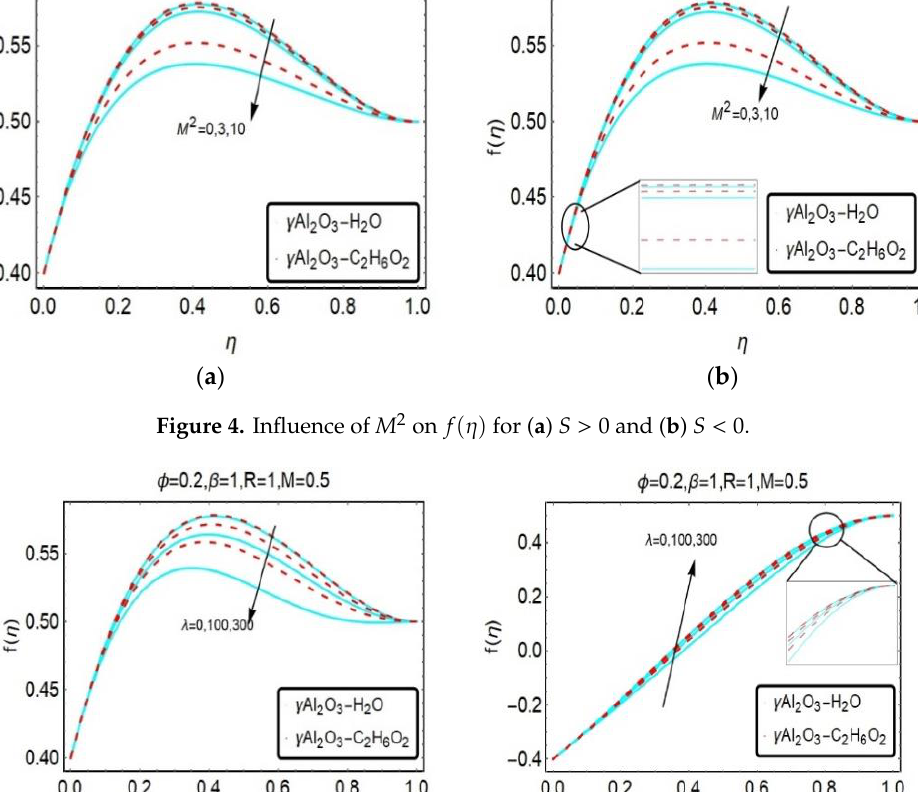
Figure 3. Influence of 𝛽 on 𝑓(𝜂) for ( a ) 𝑆 > 0 and ( b ) 𝑆 < 0 .